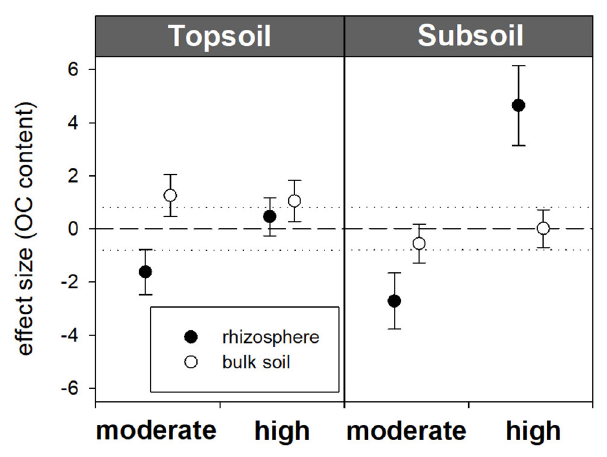
FIGURE 2 | Standardized effect sizes for total OC contents. Hedges’ g* of the exudate addition treatments compared to the water control. Bars indicate the standard error of the effect size estimate. Dotted lines mark thresholds of − 0.8 and 0.8 below or above which, respectively, effect sizes are considered as